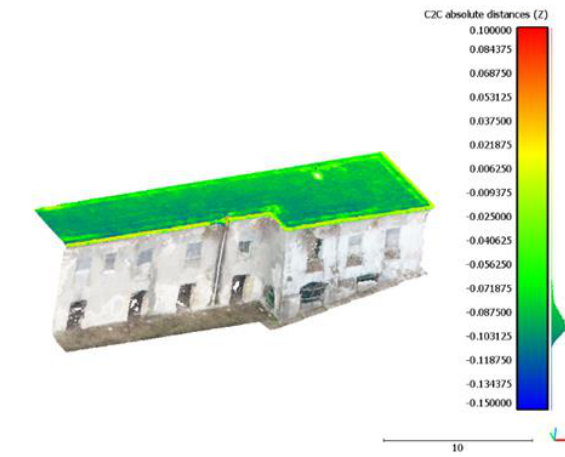
Figure 5 . Distances along the z axis resulting from the Cloud- to-Cloud application, without registration of the two clouds.